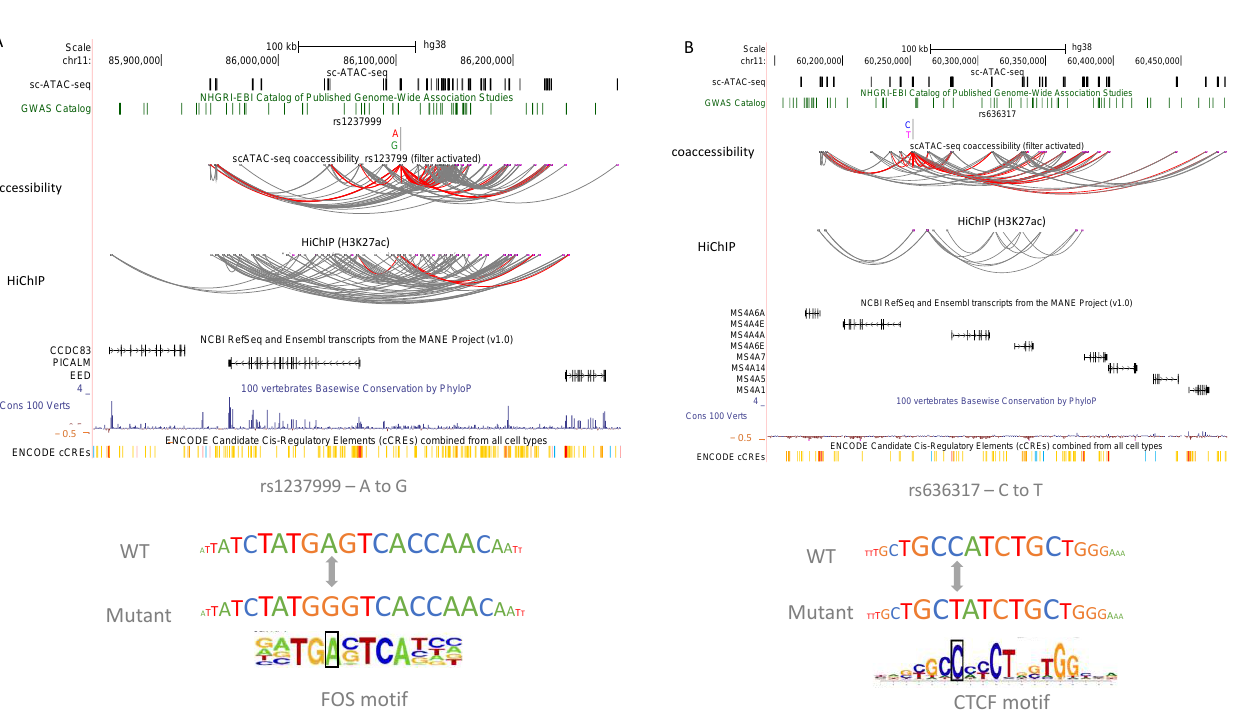
Figure 6. Visualization of scEpiLock-identified functional SNPs in AD and PD. ( A , B ) Reference genome, scATAC-seq peaks, GWAS SNPs, co-accessibility associations, H3K27ac HiChiP, nearby genes, Cons 100 Verts scores, ENCODE cCREs, and matching motifs for ( A ) rs1237999 ( B ) rs636317. Besides the top two SNPs, we also examined other top SNPs in the list. For instance, rs10769263 decreased the accessible score from 0.723 to 0.485 for microglia, which indi- cated that this mutation converted the region from accessible to non-accessible. This SNP was located 17 kb upstream from the transcription start site of the SPI1 (PU.1) gene. In